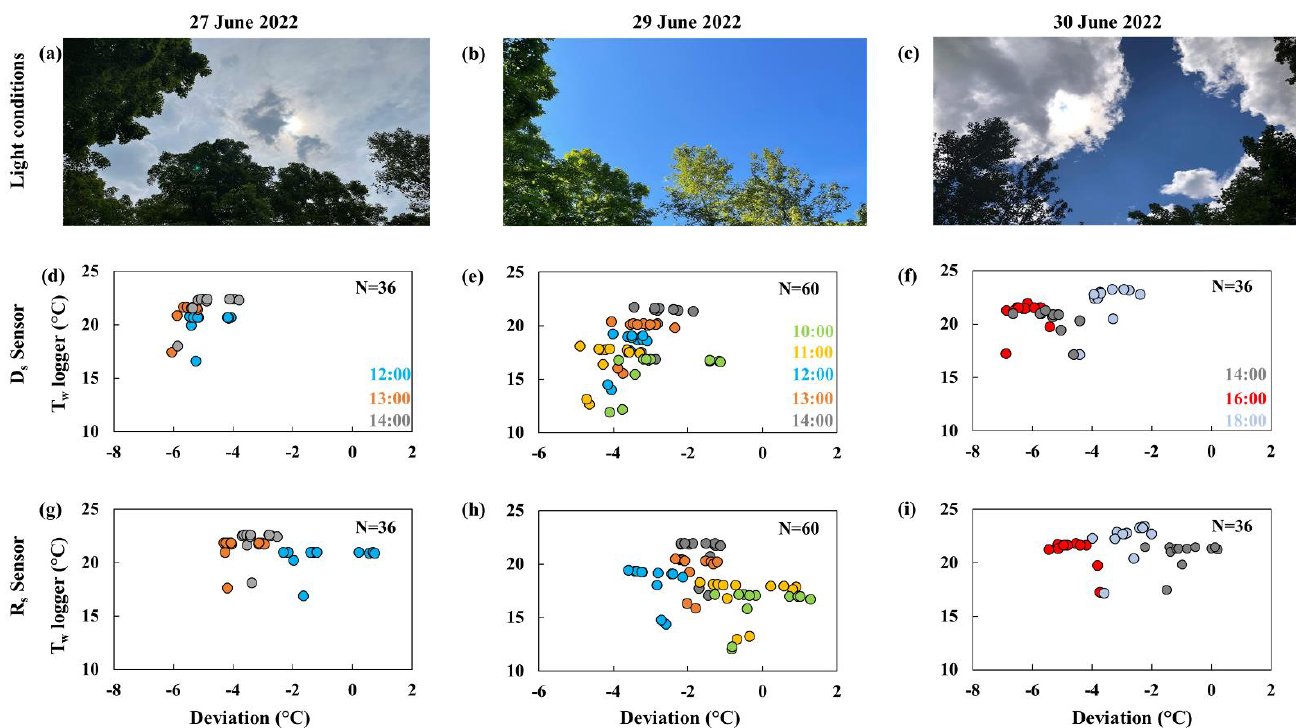
Figure 8. The cloud conditions are illustrated in ( a – c ) in concert with the deviation between the instream loggers (T w n = 12 per flight) and the TIR data from each flight; where panels ( d – f ) are the deviations for the D s sensor on 27 June ( d ), 28 June ( e ), and 30 June ( f ), and ( g – i ) represent the R s sensors deviations for the same dates, respectively.